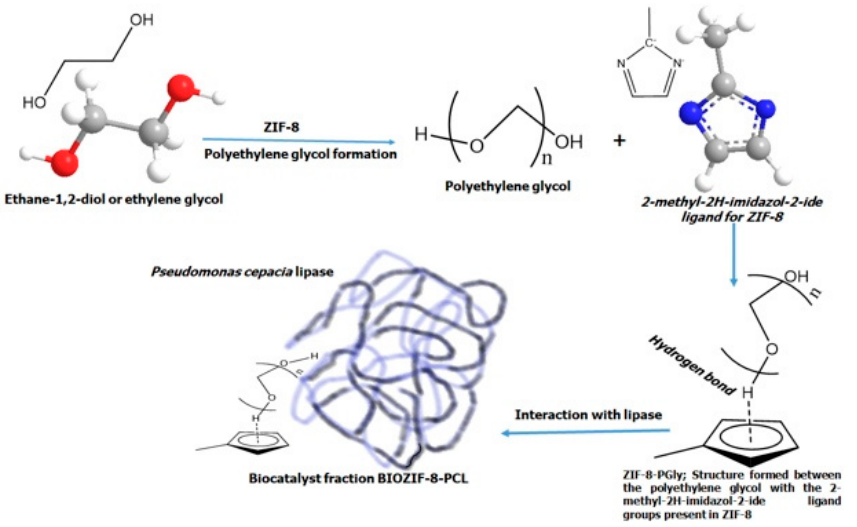
Figure 10. Formation pathway of the ZIF-8-PCL biocatalyst, starting from the interaction of ZIF-8 with ethylene glycol and the formation of polyethylene glycol and ZIF-8-PGly as an intermediate. As for the Gly@ZIF-8 formation and the calcination of ZIF-8-PGly, although gradual heating was applied, the formation of the carbonaceous network from the thermal decomposition of polyethylene glycol did not protect the ZIF-8 structure, and therefore it suffered textural and structural changes, because the thermal stability of ZIF-8 is around 550 ◦ C [62] and the structural configuration of the ZIF-8-PGly intermediate did not give it the thermal stability to withstand 900 ◦ C. However, the zinc atoms remained in the new structure, forming C-Zn bonds (see Figure 11), a fact that was evidenced by the presence of the 1358 and 1593 cm − 1 bands in the Raman spectrum of Gly@ZIF-8 (see Figure 5B). The presence of Zn atoms in the structure of Gly@ZIF-8 allows lipase anchoring because Zn induces lipase aggregation [63]; however, the distribution of Zn atoms on the surface of this porous material is not homogeneous, and many Zn atoms are immersed in the carbonaceous network, as reported by D í az Dur á n and Roncaroli for cobalt [51], hence the lower mass percentage of the FAMES components of the biodiesel (BIOGly@ZIF- 8-PCL) synthesized from Gly@ZIF-8-PCL. These structural and textural changes can be evidenced in the N 2 adsorption–desorption isotherms at 77 K of Gly@ZIF-8 and the pore size distribution curves (Figure